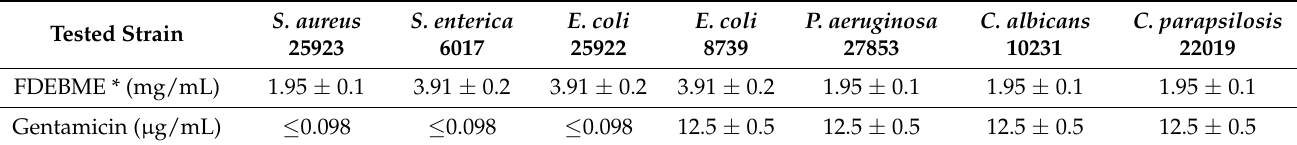
Table 2. Minimum inhibitory concentration against Staphylococcus aureus , Salmonella enterica , Escherichia coli (25922 and 8739), Pseudomonas aeruginosa , Candida albicans, and C. parapsilosis . S. aureus S. enterica E. coli E. coli 25923 6017 25922 8739 27853